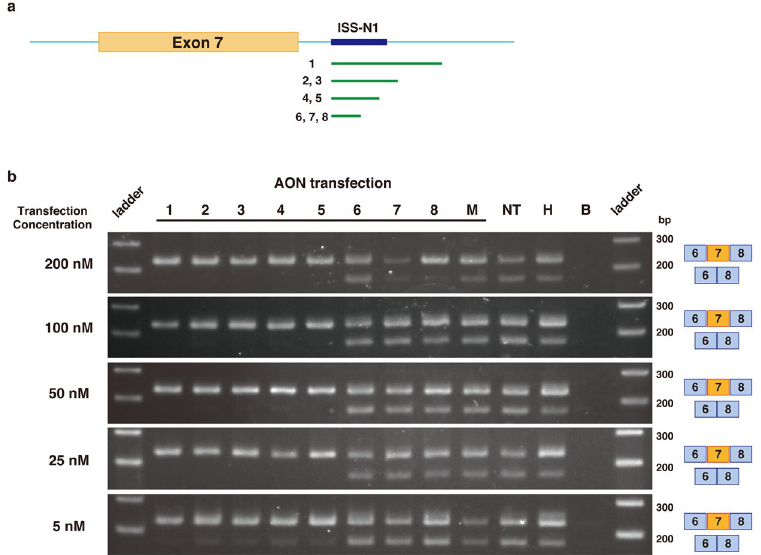
Figure 2. Newly designed AONs induce SMN2 exon 7 inclusion. ( a ) Relative positions of newly designed AONs targeting ISS-N1 in intron 7 of SMN2 . Green line: newly designed AONs (LNA/DNA mixmers). ( b ) The screen of AONs (LNA/DNA mixmers) by RT-PCR of SMN2 in human SMA patient fibroblasts (GM03813). Transfection of AONs was performed at 200, 100, 50, and 5 nM. Transfection of at least 5 nM of AONs #1–5 induced the exon 7 inclusion. Top band: exon 7-included. Bottom band: exon 7-excluded. M: mock control AON, NT: non-treated, H: healthy cells, B: